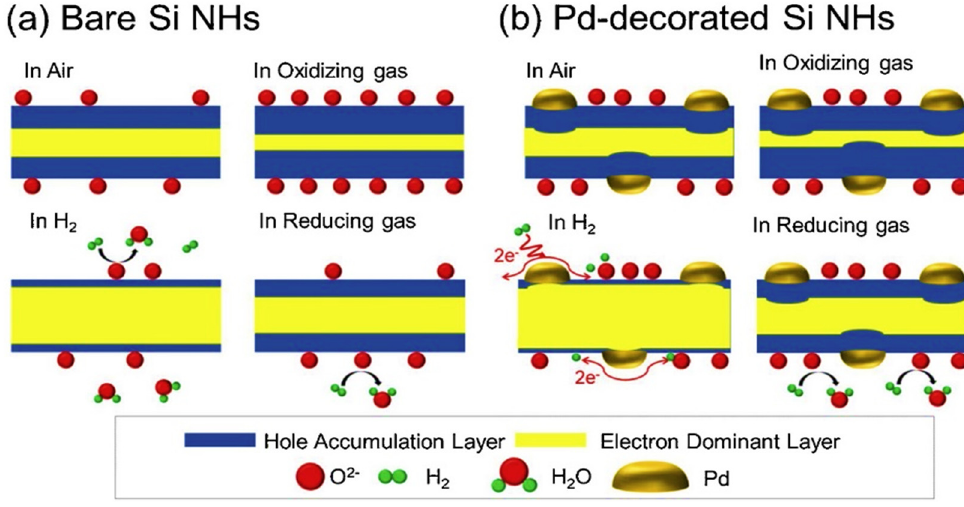
Figure 37. Schematics of the sensing mechanisms of ( a ) pristine Si-NHs and ( b ) Pd-decorated Si-NHs. Reproduced from [168] with the permission of Elsevier.